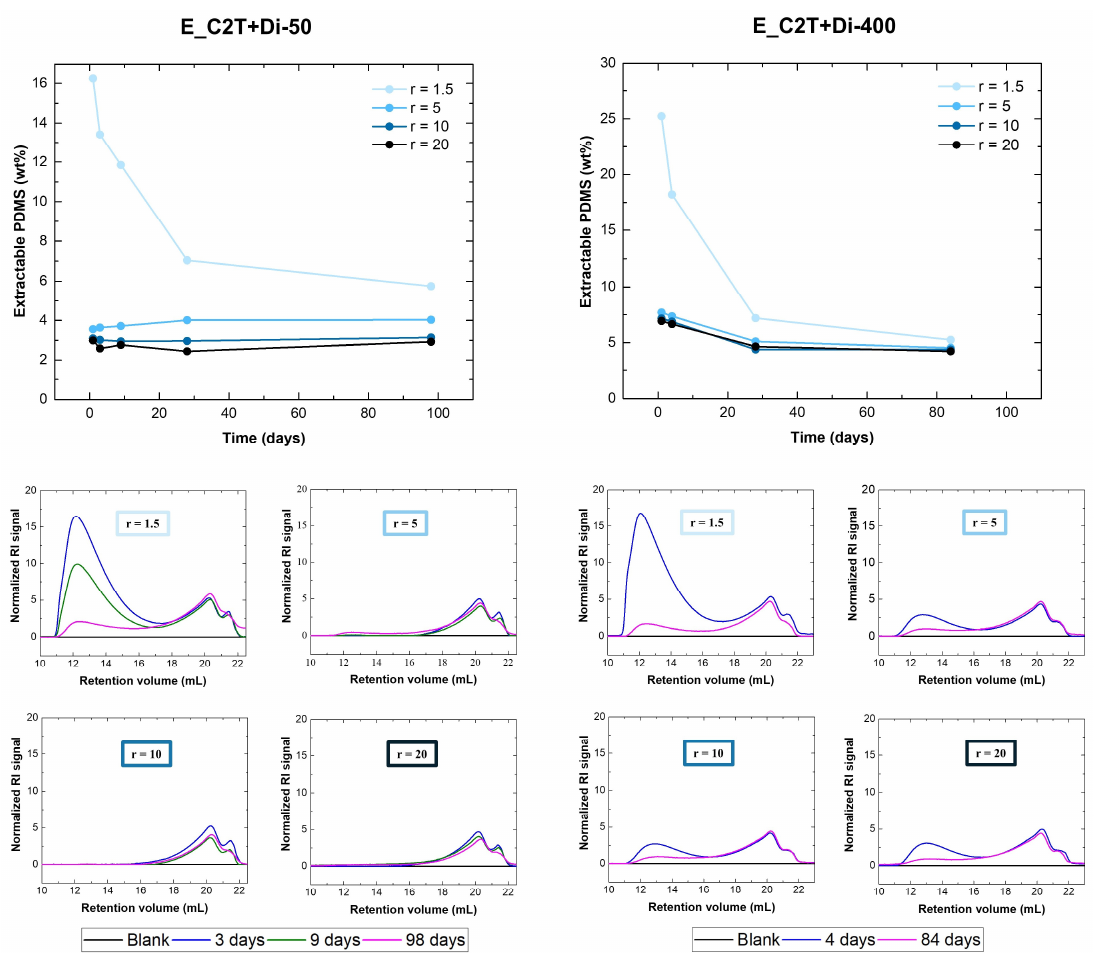
Figure 4. ( Top ) Extractable PDMS (wt%) as a function of time (determined from 1 H NMR analysis). ( Bottom ) SEC eluograms of the extractable PDMS. Analyses were performed on elastomers prepared via the reaction of C2T with Di-50 and Di-400, respectively. The stoichiometric ratio was varied from 1.5 to 20. Film thickness was ~100 µm.